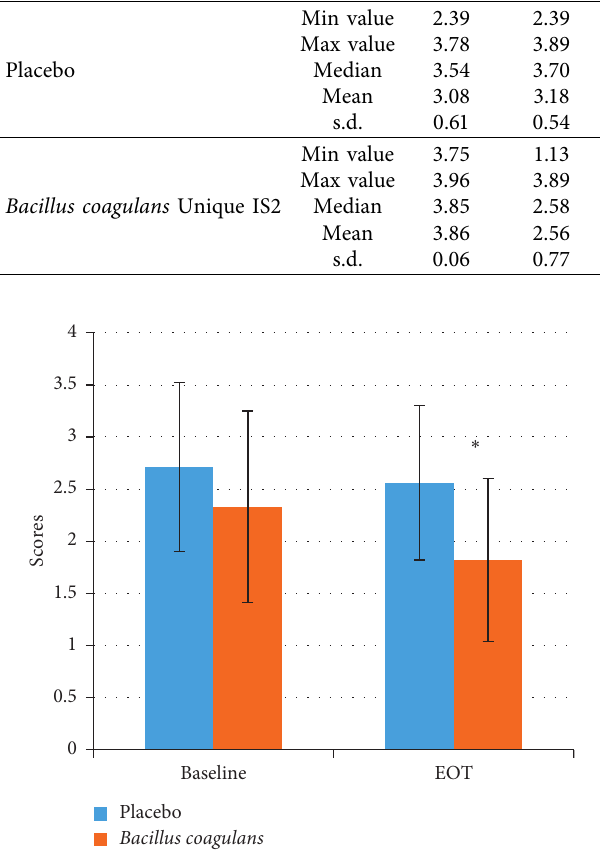
Figure 3: Plaque mutans streptococci scores at baseline and EOT. Values are mean ± s.d. ∗ p value < 0.05.